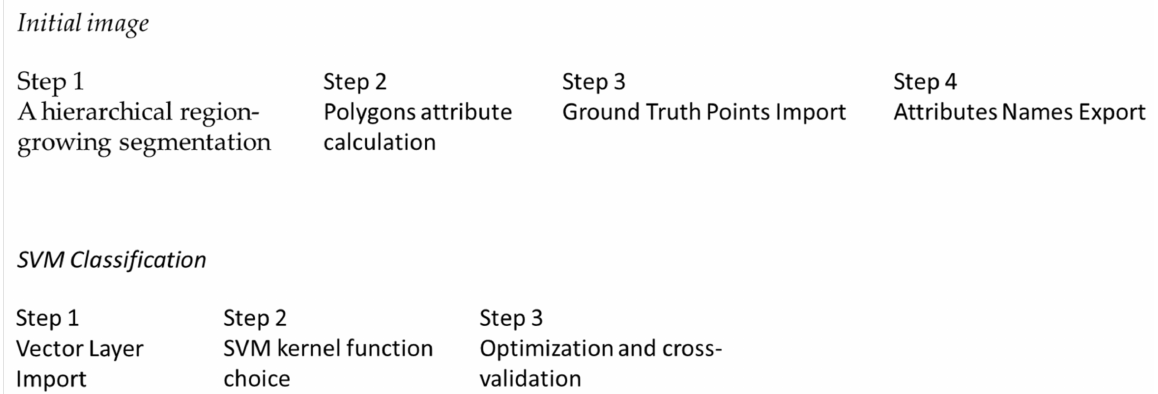
Figure 3. Basic SVM classification